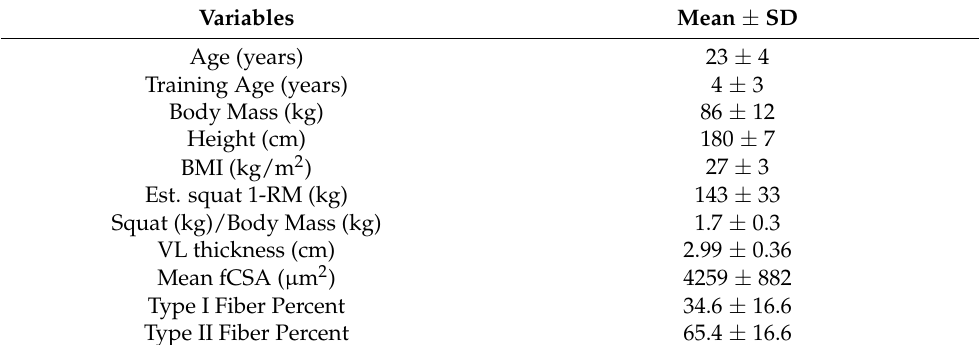
Table 1. Participant